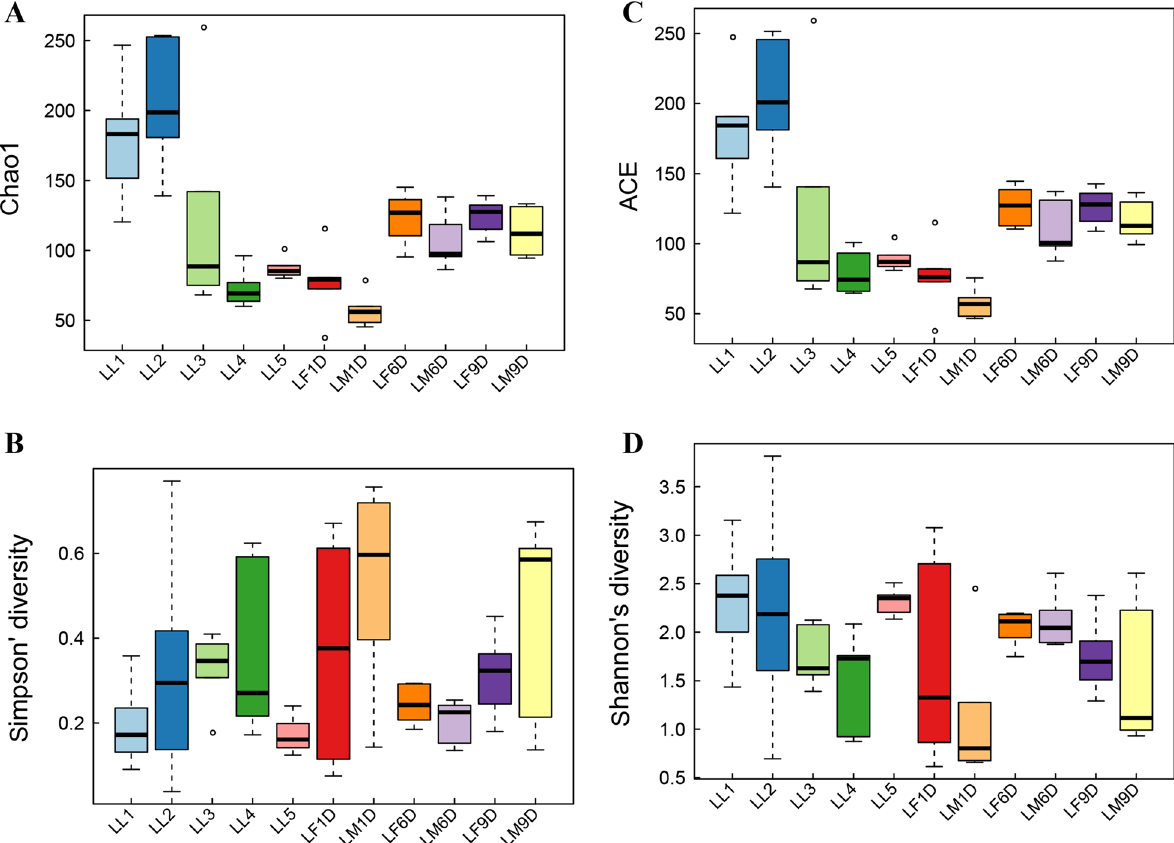
Fig. 2 Sequencing analysis of 16S rRNA gene amplicons of A. lucorum with diversity indices. A Chao1 index, B Simpson’ diversity, C ACE index, D Shannon’s diversity. “°” indicates an